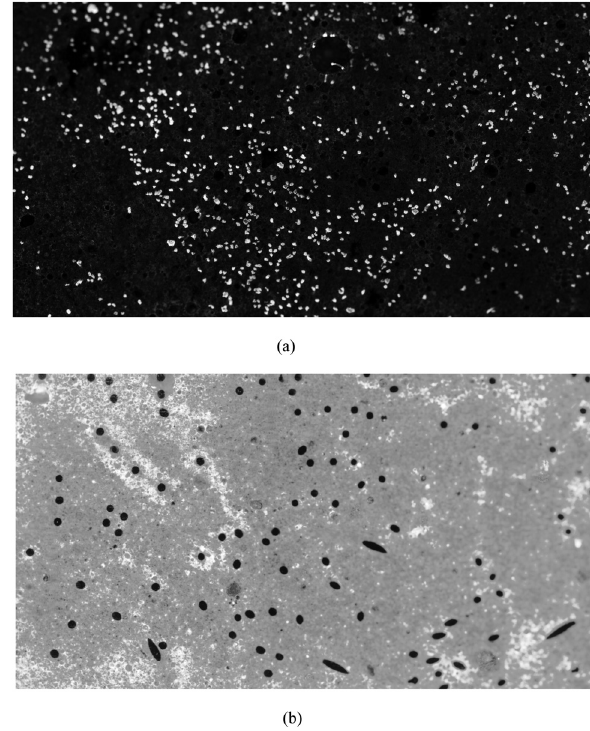
Figure 15: Fiber dispersion in lightweight cement - based composites. ( a ) PVA; ( b )